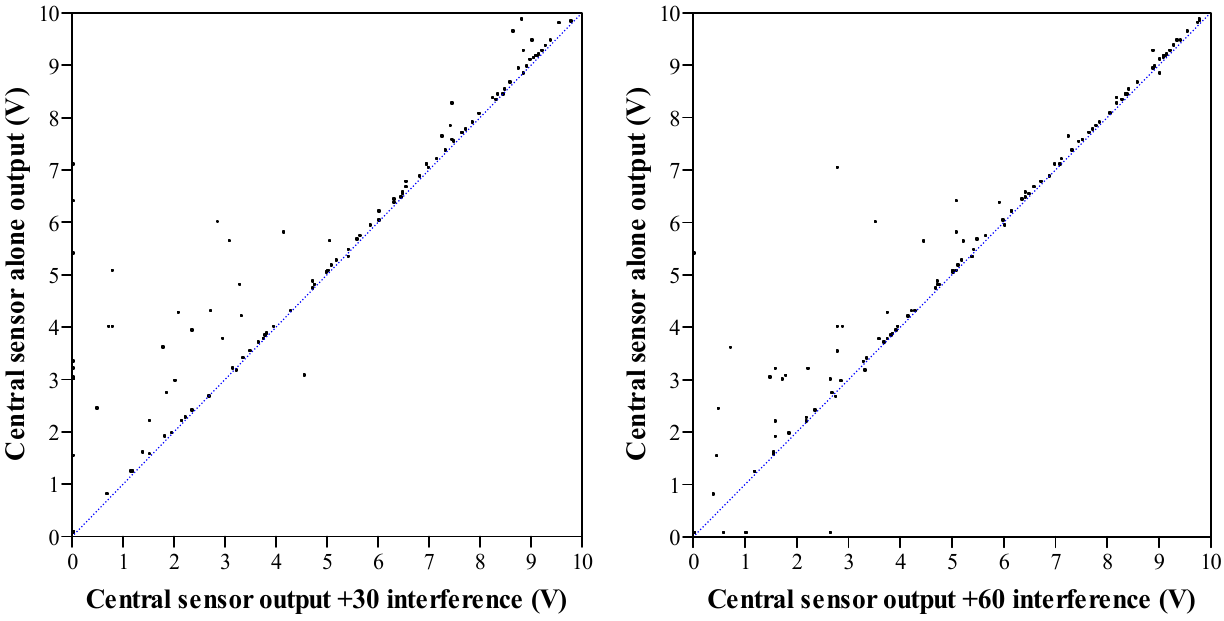
Figure 11. Scatter diagram of central sensor alone output and simultaneously working with adjacent sensors at ±30 cm ( left ) and with adjacent sensors at ±60 cm ( right ) during the field interference trial. Blue lines represent